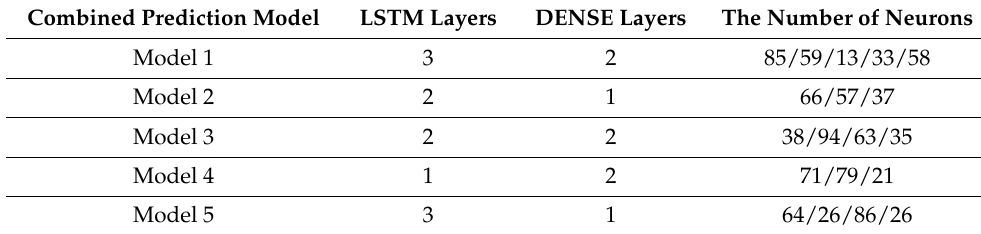
Table 4. Optimal structural parameters of each prediction model.